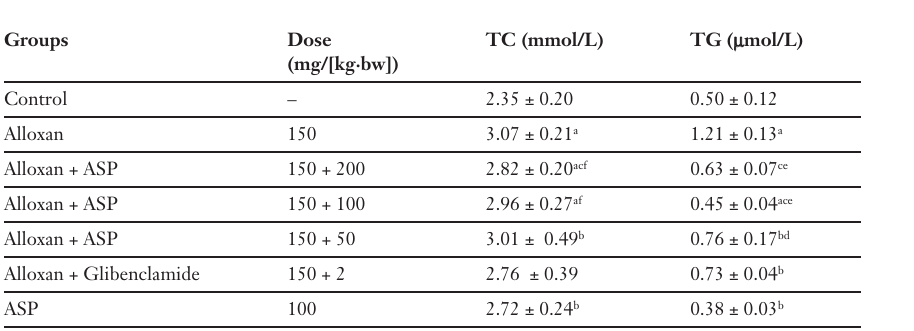
Effect of ASP on TC and TG in alloxan- induced diabetic rats.